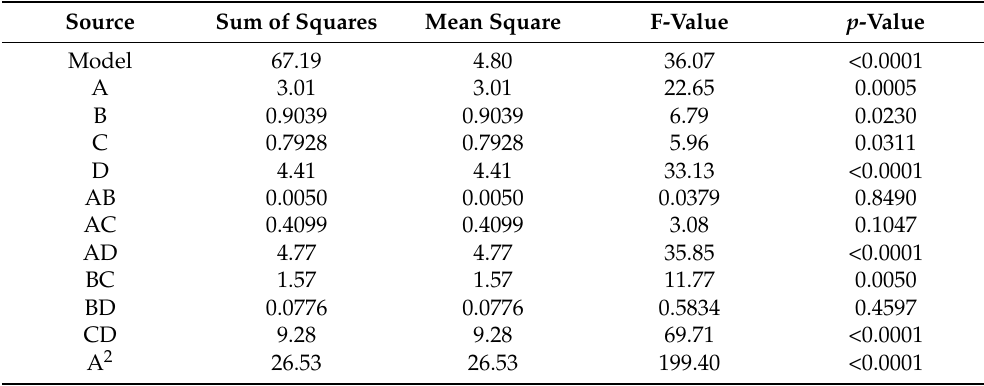
Table 3. Analysis of variance (ANOVA) for testing the fitness of the regression equation. Source Sum of Squares Mean